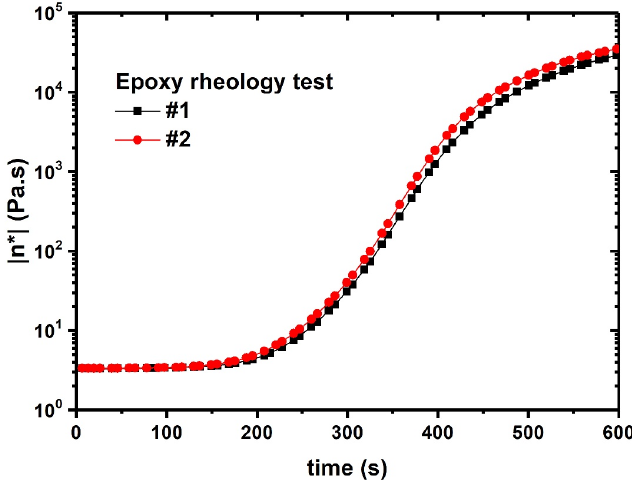
Figure 11. Viscosity measurement of epoxy at 90 °C with parallel plate rheometry. Films were obtained by spin coating on a spherical surface, and the thickness of the films was measured to validate the proposed